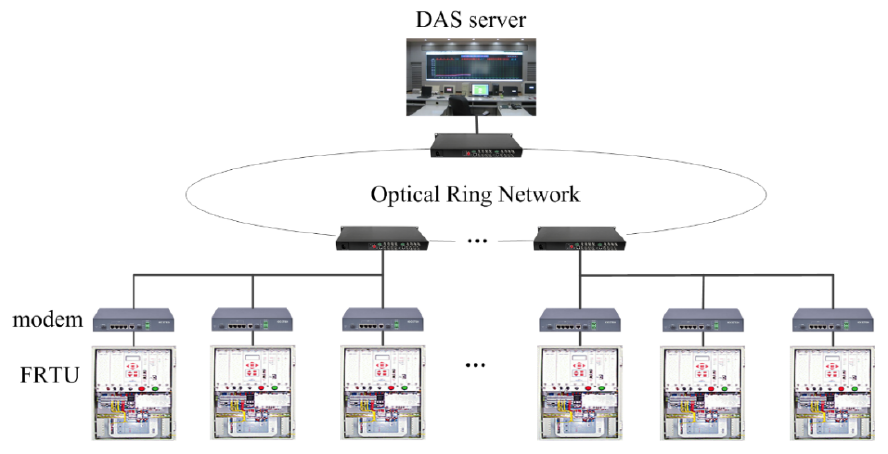
Figure 1. DAS communication